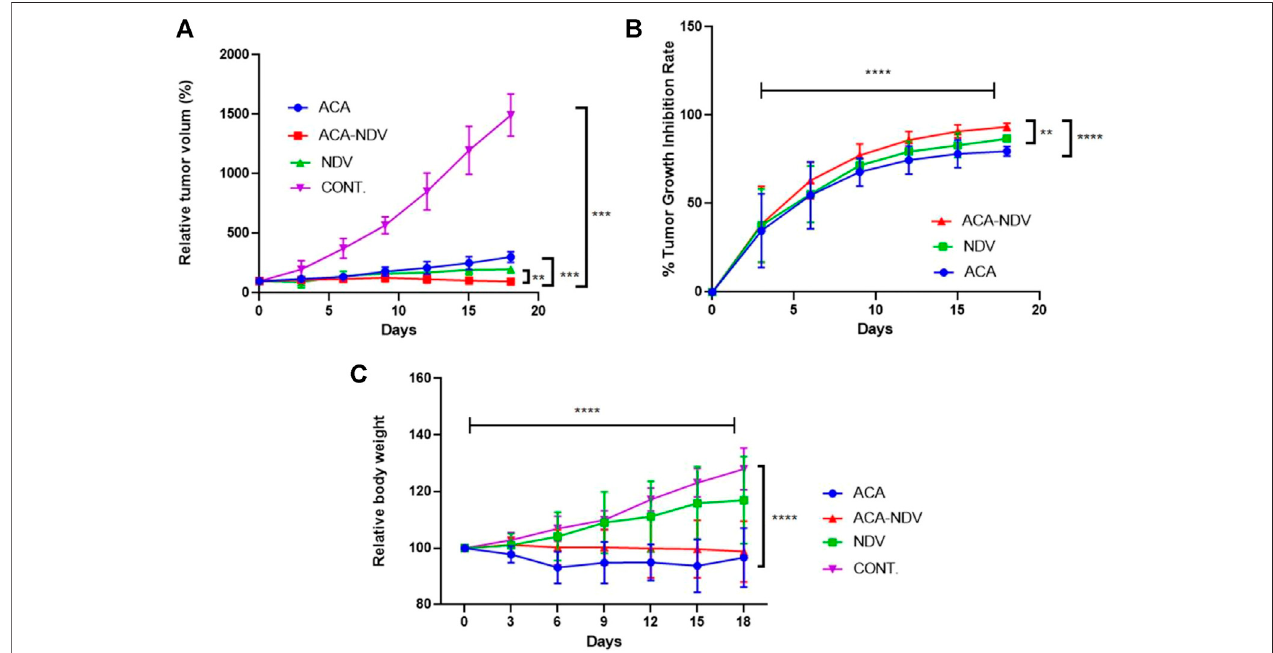
FIGURE 1 | Antitumor ef fi cacy of acarbose (ACA), Newcastle Disease Virus (NDV), and a combination of both against a mammary adenocarcinoma AN3 in vivo model. (A) Relative tumor volumes over 18 days were plotted. Compared to the control group, ACA, NDV, or a combination of both generated a signi fi cant( p < 0.0001) decrease in relative tumor volume. Compared to both monotherapy groups, the combination therapy of acarbose and Newcastle Disease Virus (ACA-NDV) demonstratedsigni fi cantlygreatertumor sizereduction. (B) eGrowthinhibitioncurvedemonstrated thatthecombined therapygrouphadthehighestoveralltumor growth inhibition, followed by the NDV group. The ACA group showed the least growth inhibition. In the control group, the tumors continued to grow during the experiment. (C) ACA ef fi ciently reduced body weight in mice bearing breast cancer. Bodyweight measured after treatment with ACA, NDV, and combination every 3 days indicates that ACA induces a marked decrease in body weight. By contrast, NDV did not induce a signi fi cant effect on body weight. pppp p < 0.0001, ppp p < 0.001, pp p < 0.01, and p p < 0.05versus